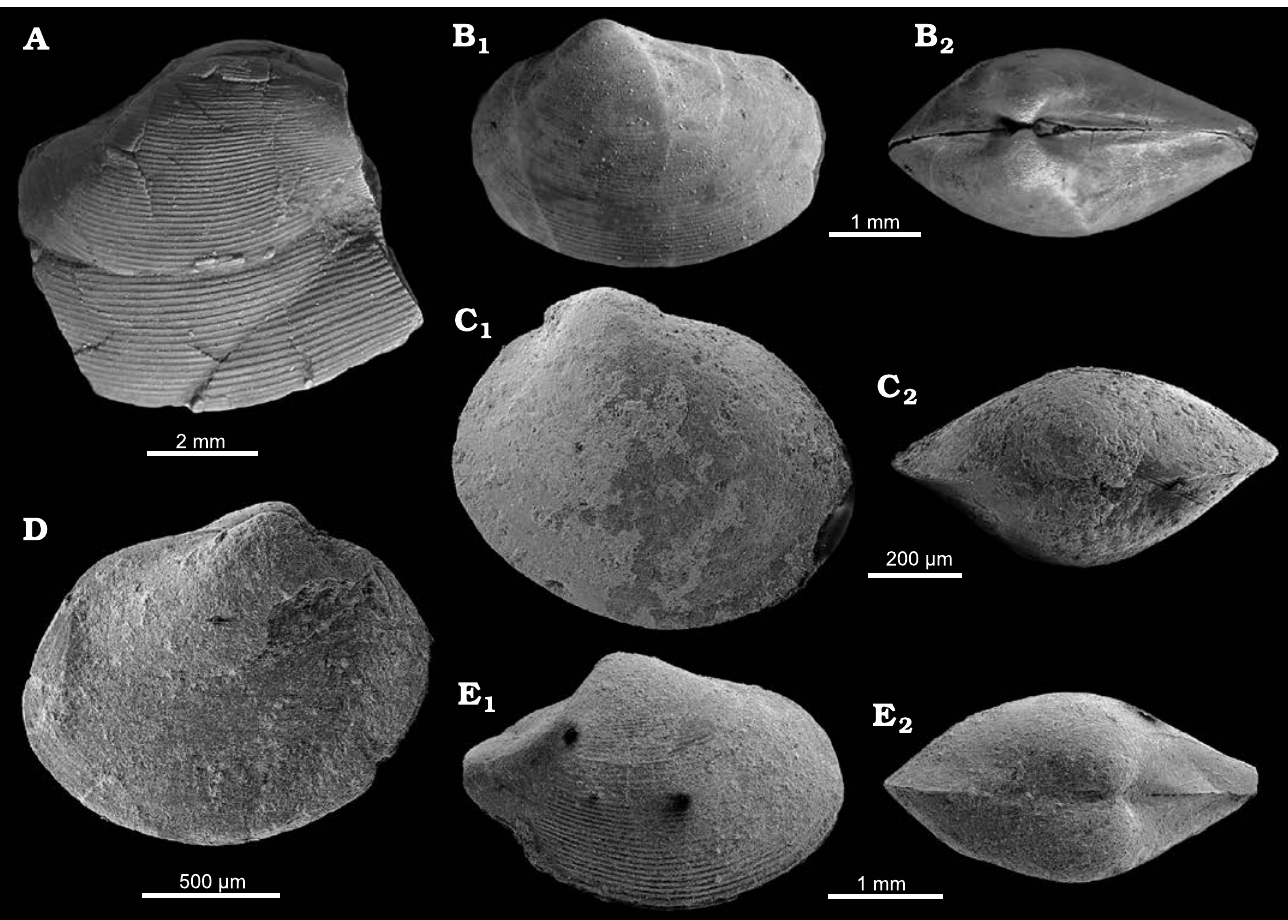
Fig. 26. Nuculid bivalves from Lago Antorno (A, B) and Misurina Landslide (C–E), northern Italy, Cassian Formation, Carnian, Upper Triassic. A . Nucu- lana sulcellata (Wissmann, 1841), PZO 12857, in lateral view. B . Palaeoneilo elliptica (Goldfuss, 1837), PZO 12859, in lateral (B 1 ) and dorsal (B 2 ) views. C . Palaeonucula strigilata (Goldfuss, 1837), PZO 12742, in lateral (C 1 ) and dorsal (C 2 ) views. D . Palaeonucula strigilata (Goldfuss, 1837), PZO 12743, in lateral view. E . Nuculana sulcellata (Wissmann, 1841), PZO 12745, in lateral (E 1 ) and dorsal (E 2 )